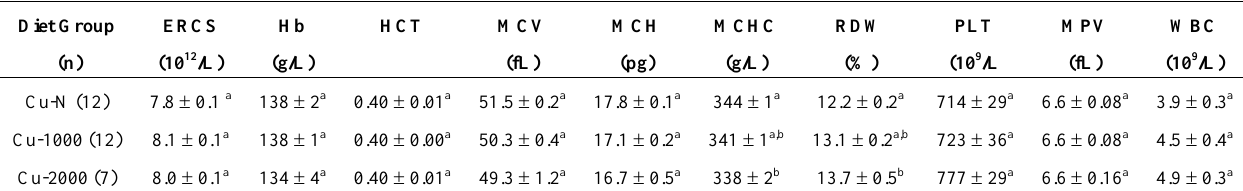
Table 2. Erythrocytes (ERCS), haemoglobin (Hb), haematocrit (HCT), mean corpuscular volume (MCV), mean corpuscular haemoglobin (MCH), mean corpuscular haemoglobin concentration (MCHC), red cell distribution width (RDW), platelet count (PLT), mean platelet volume (MPV) and white blood cells (WBC) of rats fed diets normal or high in Cu for 13 weeks 1